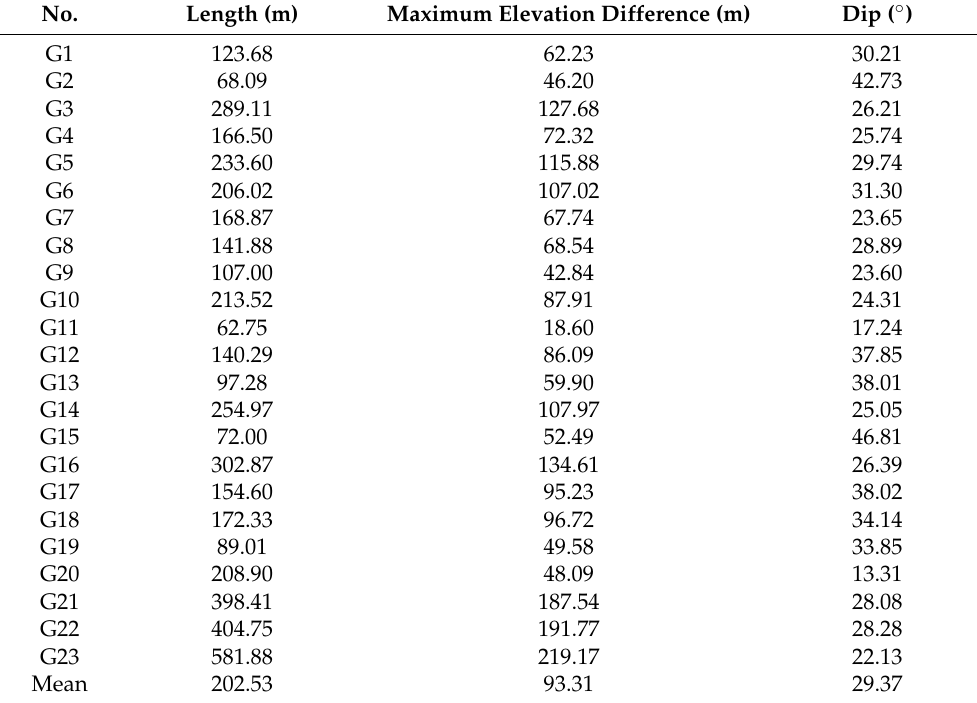
Table 4. Measurement results of valley lines’ morphological